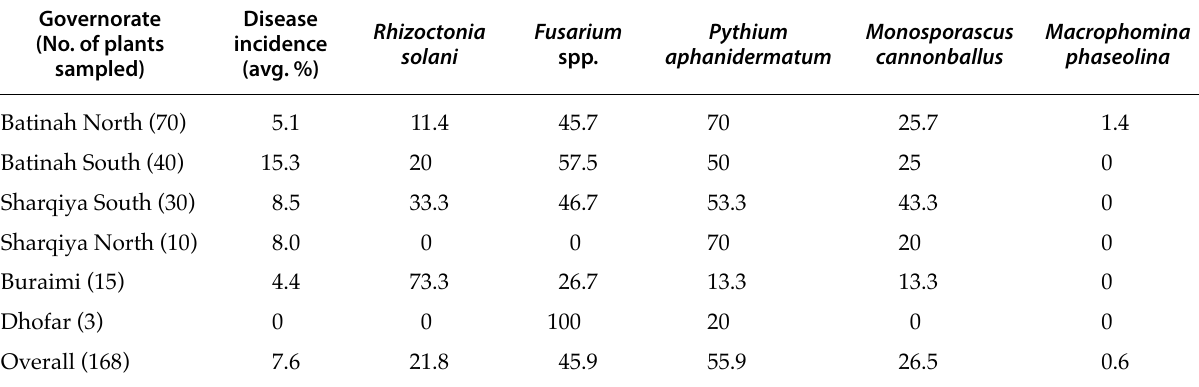
Table 2. Incidence (%) of vine decline and frequency of recovery (%) of fungi from declining muskmelon plants in six re- gions (governorates) in Oman. Values in columns represent percentage of total number of plants sampled from which each fungus was